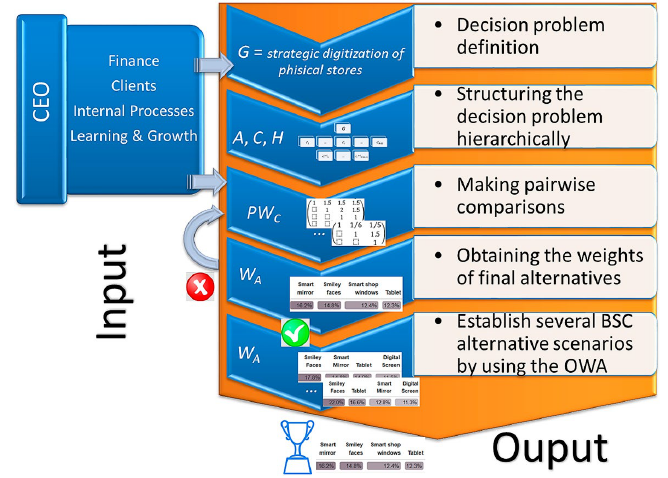
Figure 4. Proposed MCDM model to strategic digitization of physical